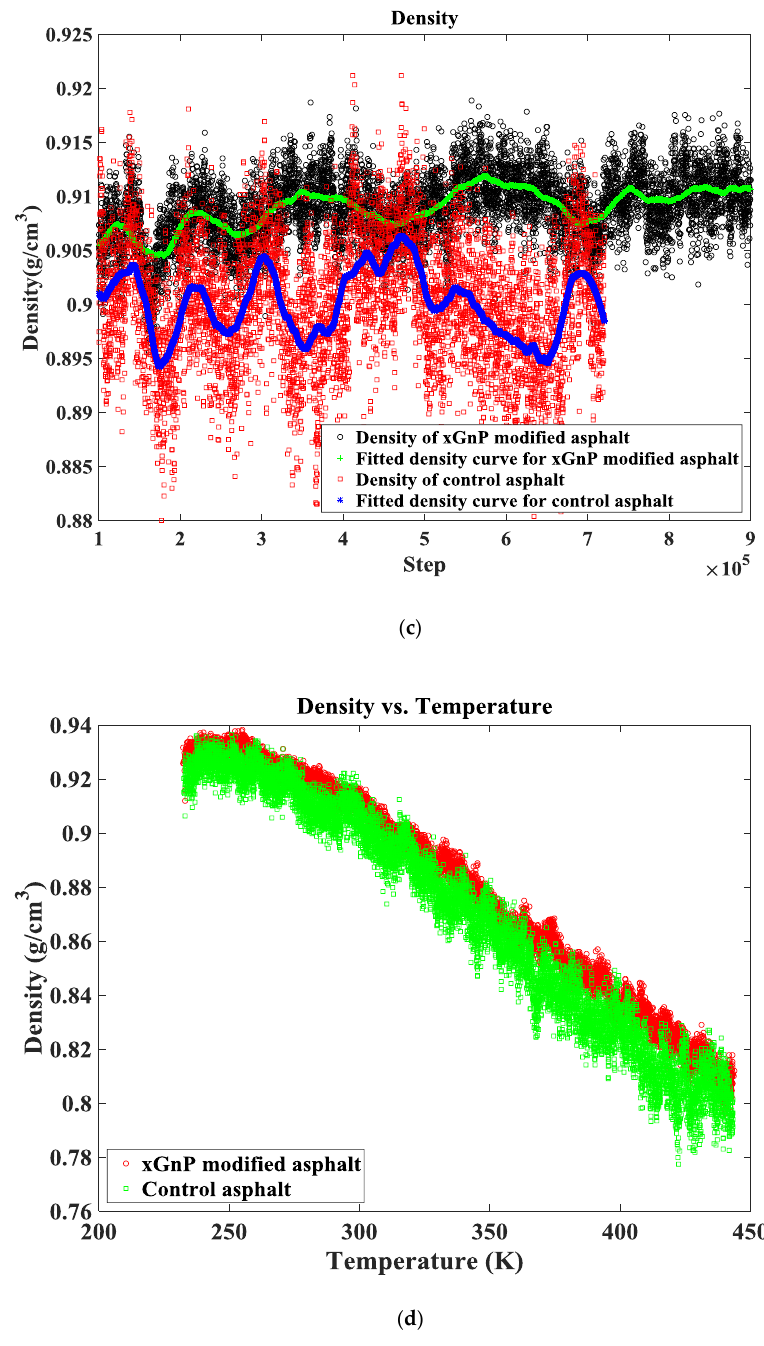
Figure 3. Density curves of the control and xGNP modified asphalt models. ( a ) Temperatures in the xGNP modified asphalt system through these steps; ( b ) Pressures in the xGNP modified asphalt; ( c ) Densities of the control and xGNP modified asphalt systems system through these steps; ( d ) Densities of the control and xGNP modified asphalt systems at different temperatures.